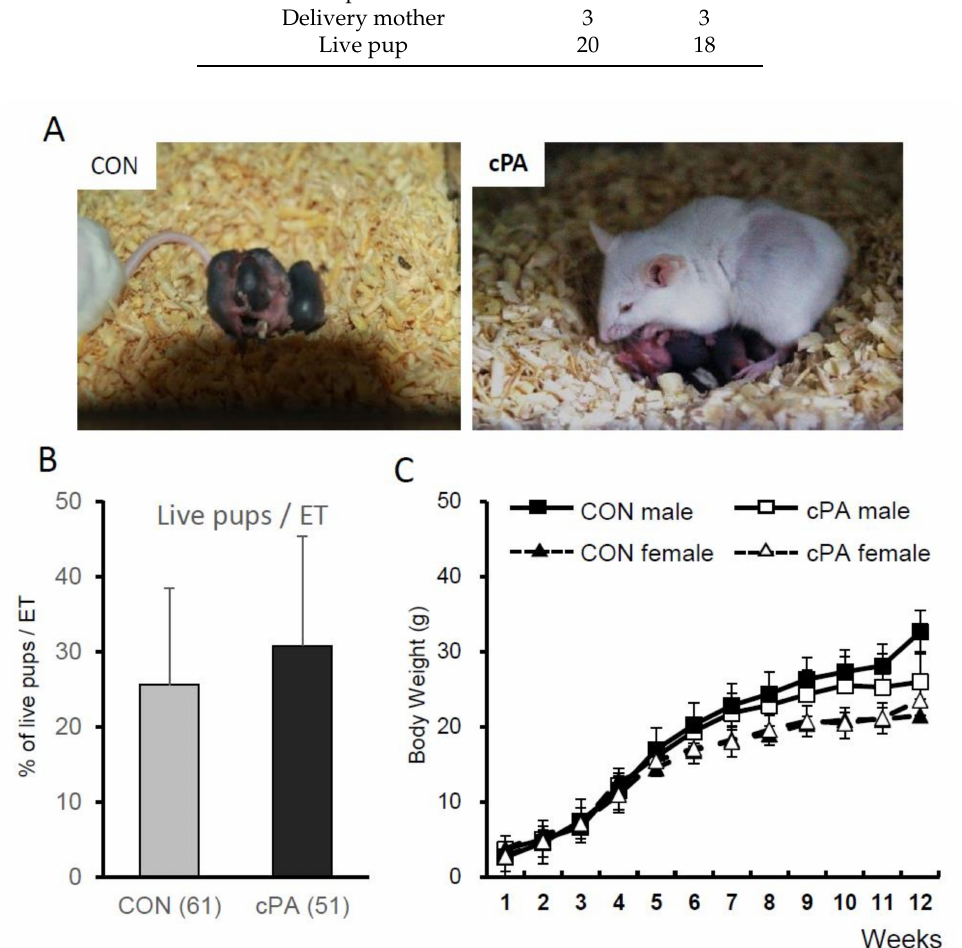
Figure 6. Birth of live pups after embryo transfer into recipient mice. ( A ) Live pups from control (CON) and cPA-treated ovaries. Sex ratios ( B ) and changes in body weight in live pups ( C ). Immature oocytes were collected from transplanted ovaries and matured in vitro, followed by in vitro fertilization. Embryos were transferred into 8-week-old pseudopregnant female